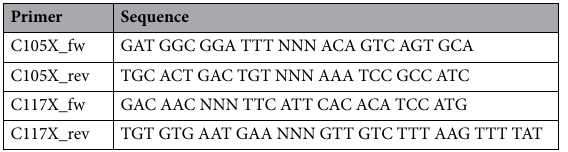
Table 5. Degenerate primers for overlapped